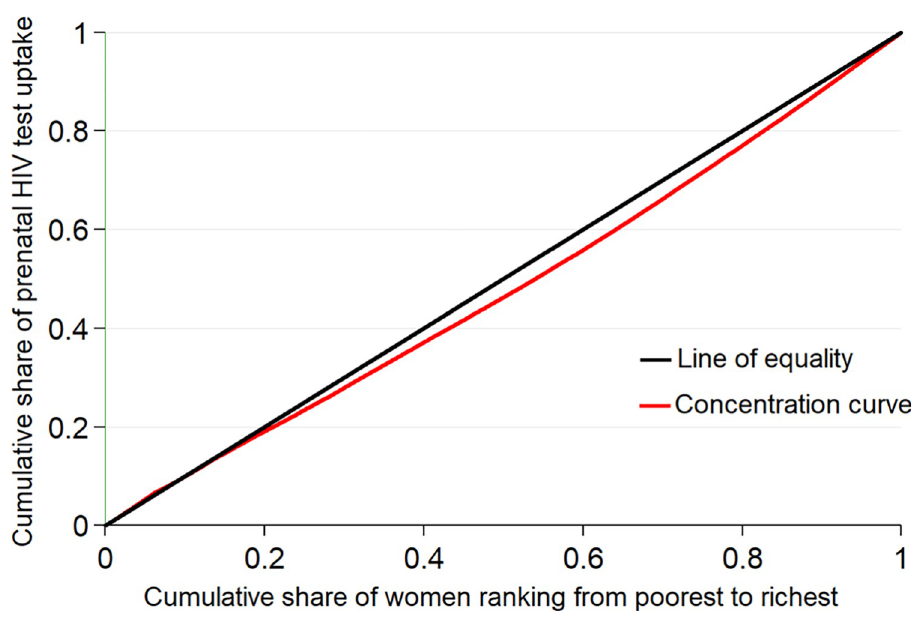
Fig 1. The concentration curve for prenatal HIV test service uptake for PMTCT in East Africa.